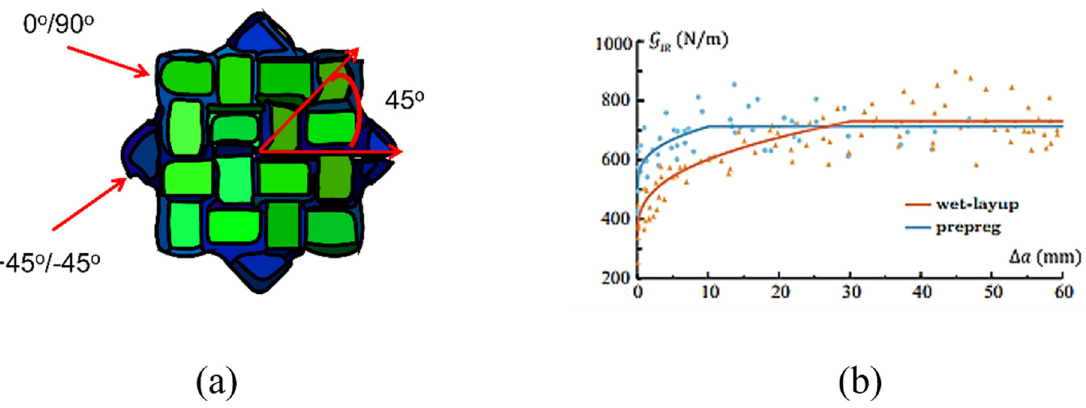
Figure 8. Stacking sequence of multidirectional laminated composite (woven prepreg) ( a ); Fatigue delamination resistance curves of prepreg and wet-layup ( b ) [44].